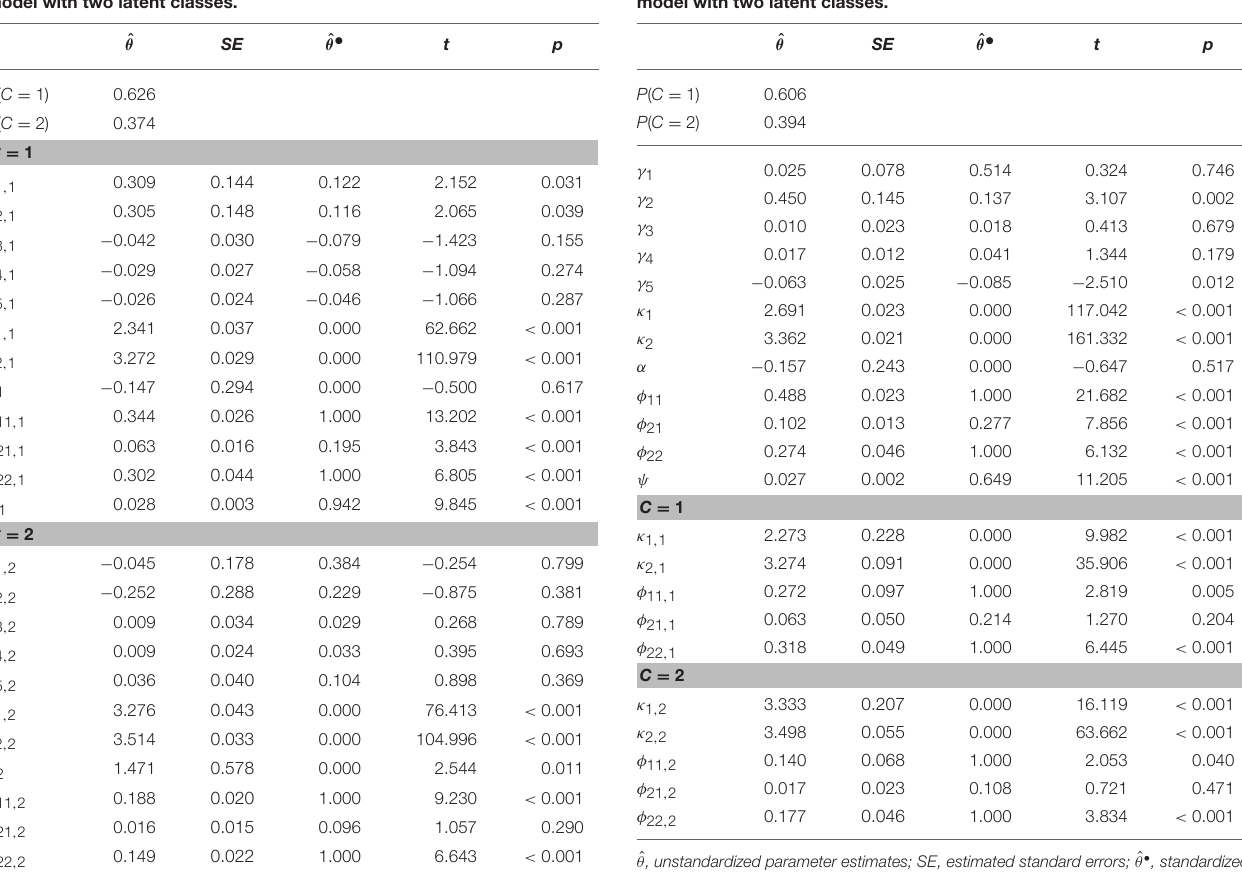
TABLE 3 | Unstandardized and standardized parameter estimates, standard errors, t - and p -values for the indirect application of a nonlinear model with two latent